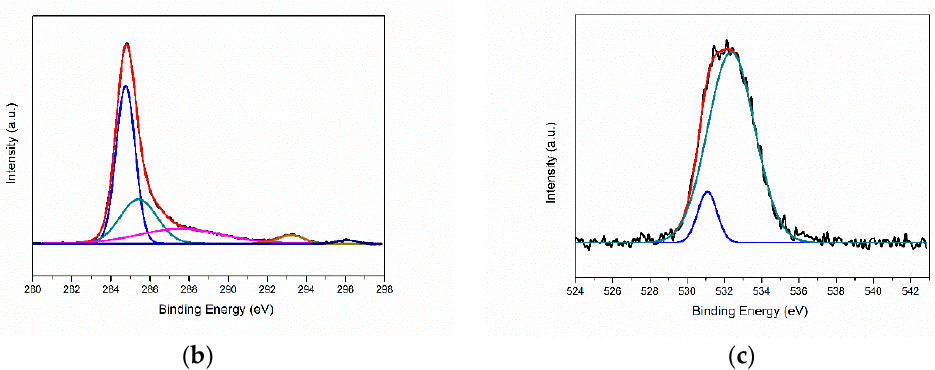
Figure 9. XPS spectra for CGB powder ( a ) survey, ( b ) high-resolution C and ( c ) high resolution O.